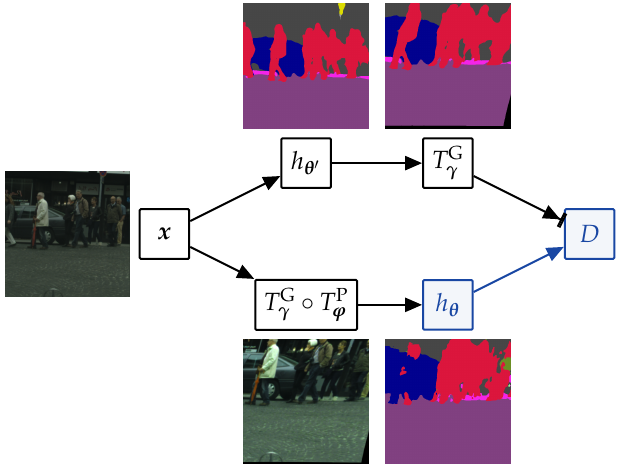
Figure 2. Dense one-way consistency with clean teacher. Top branch: the input is fed to the teacher h θ (cid:48) . The resulting predictions are perturbed with geometric perturbations T G γ . Bottom branch: the input is perturbed with geometric and photometric perturbations and fed to the student h θ . The loss D corresponds to the average pixel-wise KL divergence between the two branches. Gradients are computed only in the blue part of the